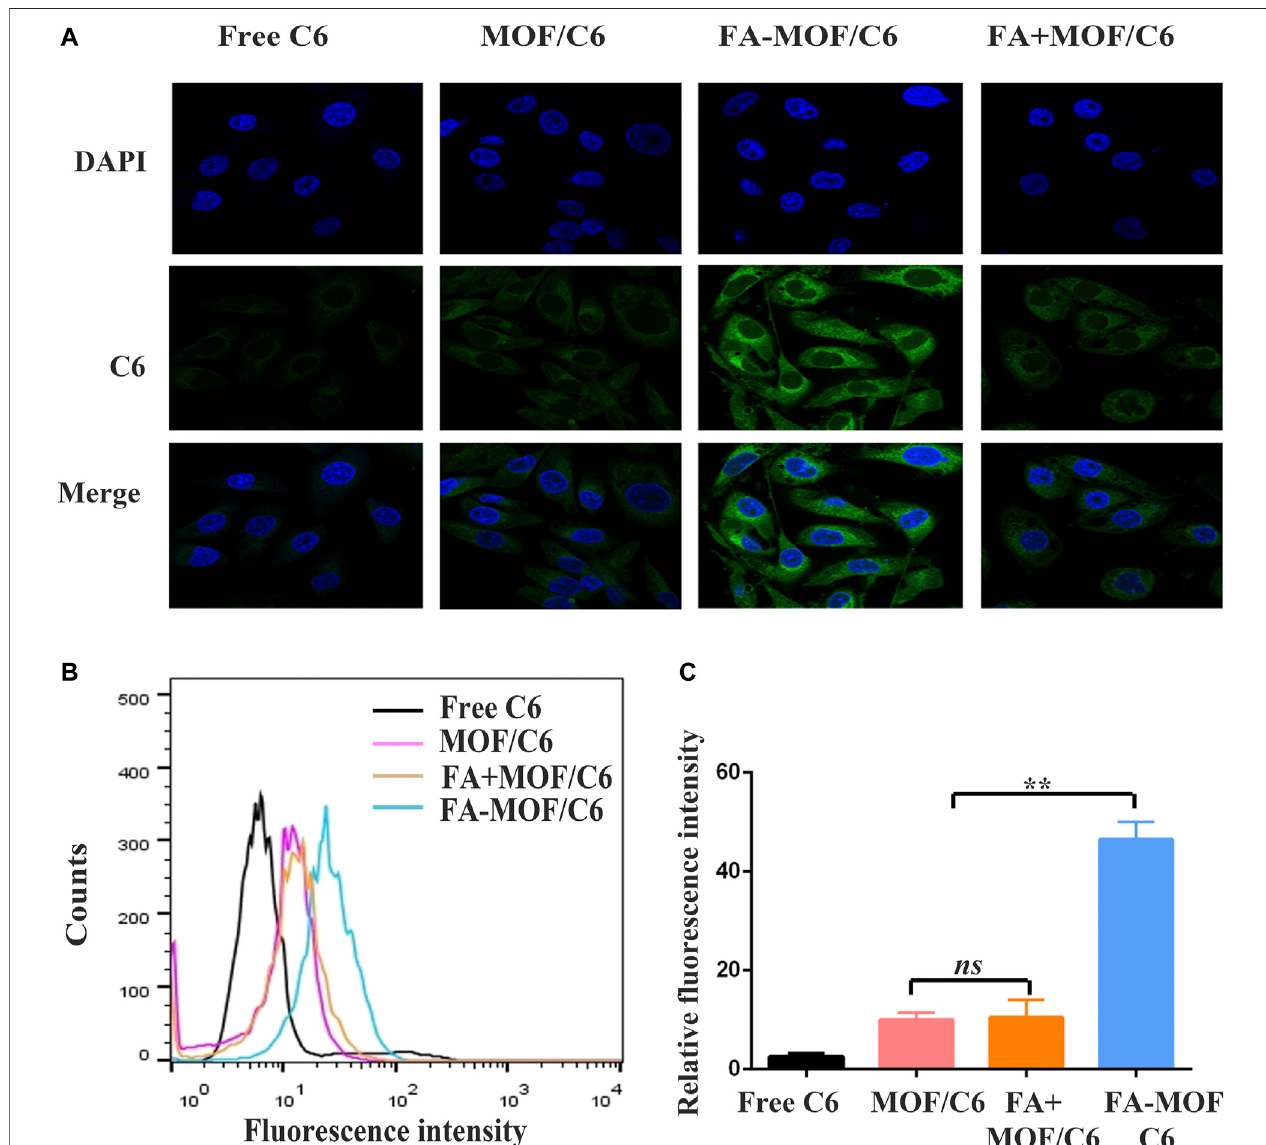
FIGURE 3 | In vitro cellular uptake and folic acid competition assay. MCF-7 cells incubation with free C6, C6-labeled MOF (MOF/C6), C6-labeled FA-MOF (FA-. MOF/C6),andC6-labeledMOFcombinedwith1 mMfolicacid(FA + MOF/C6)for2 h. (A) Fluorescenceimagesofcellswereobtainedbyusingaconfocallaserscanning microscope; the scale bar was 20 µm. (B) Uptake ef fi ciency on MCF-7 cells was obtained by fl ow cytometry and quantitative analysis. (C) ** p < 0.01.